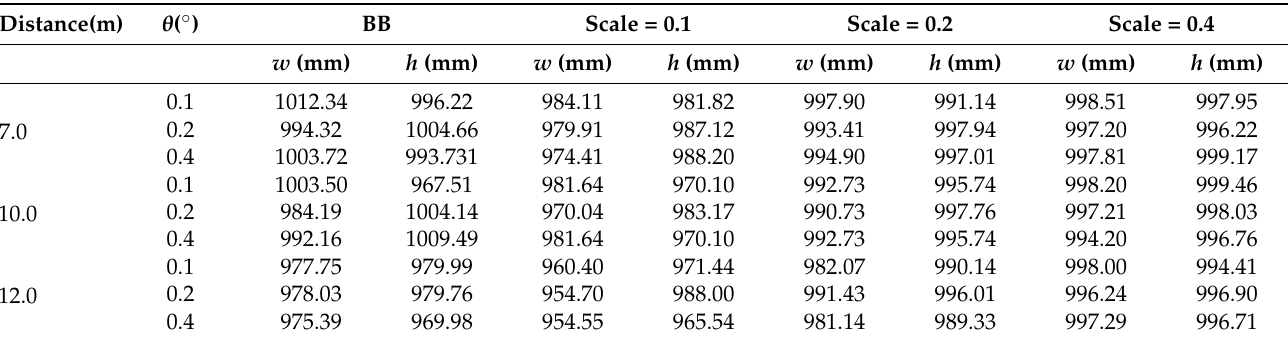
Table 2. Calibration board size measurement results.